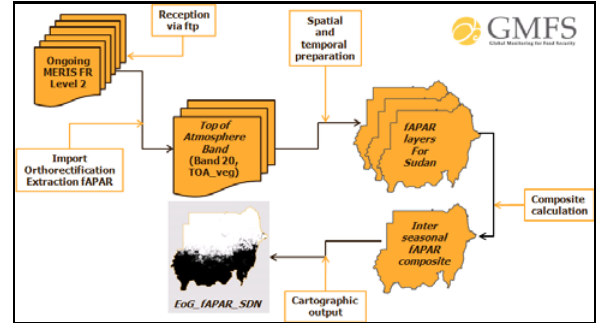
Figure 1 Indicative fAPAR map Processing Chain